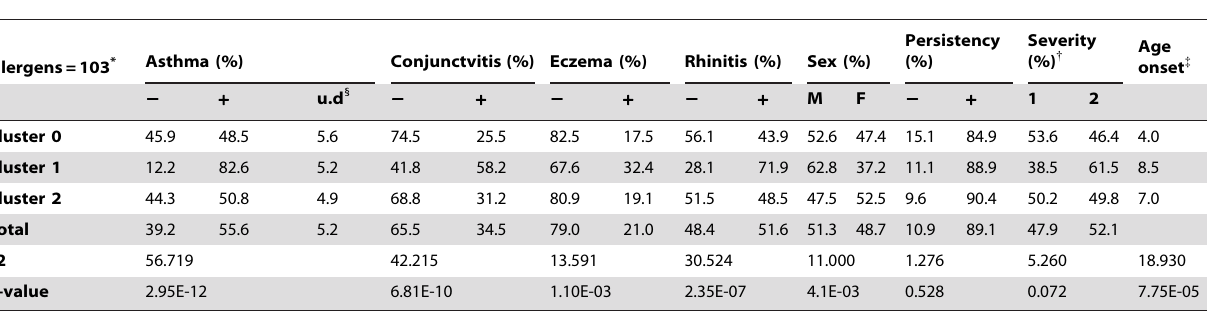
Table 2. Distribution of atopic traits amongst the reactivity